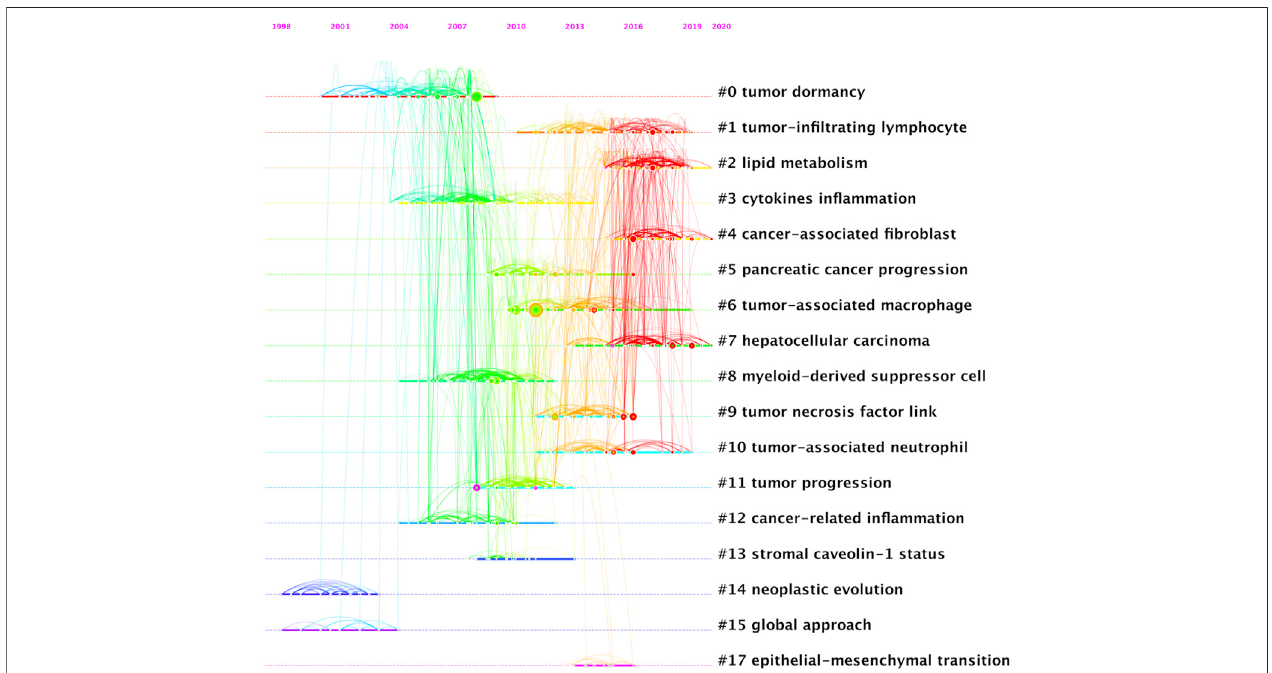
FIGURE 6 | Timeline view of co-citation clustering knowledge map of the in fl ammatory tumor microenvironment.